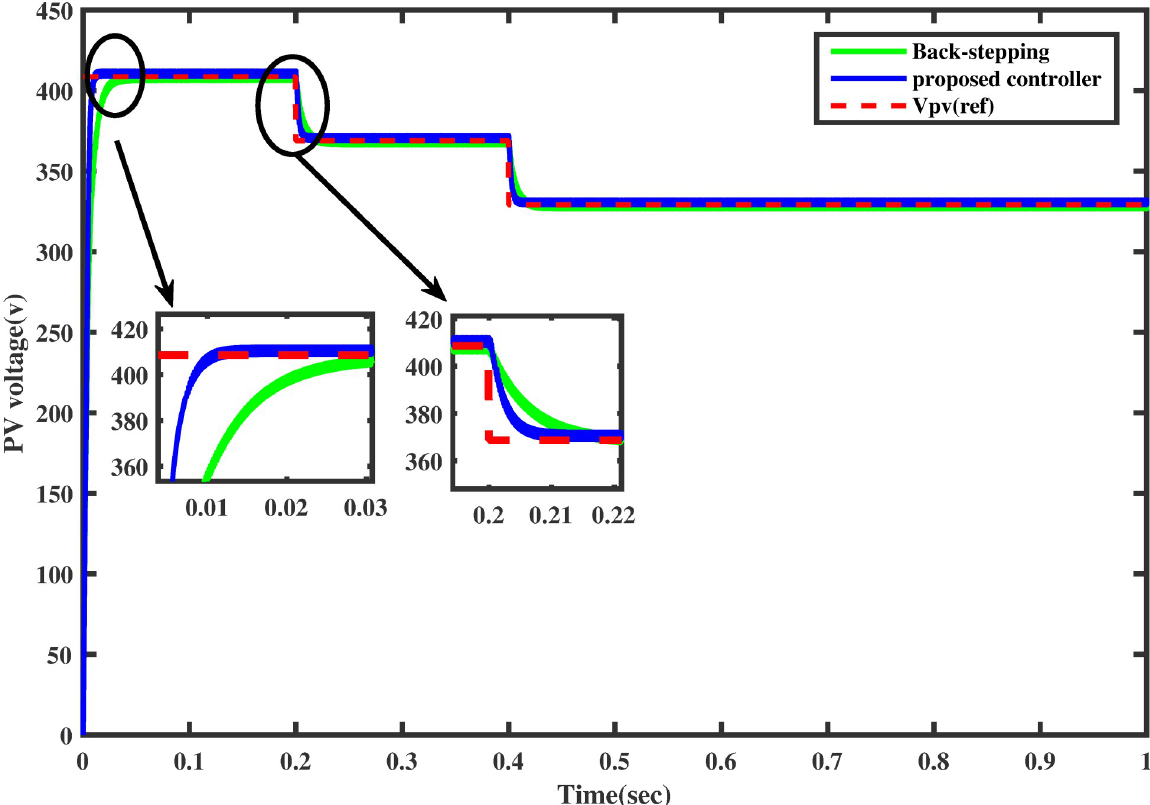
Fig 20. Comparison of PV array voltage under varying